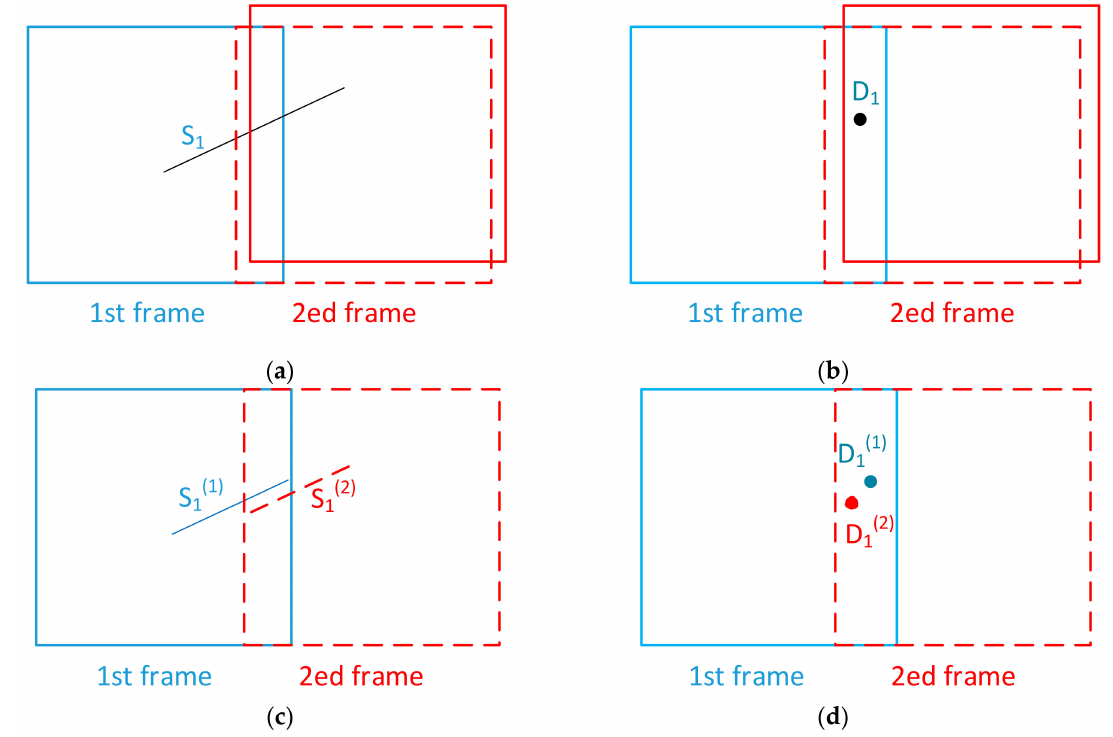
Figure 4. Mismatches that increase the number of defects. ( a ) Actual scratch; ( b ) Actual dig; ( c ) Mismatch for scratch; ( d ) Mismatch for